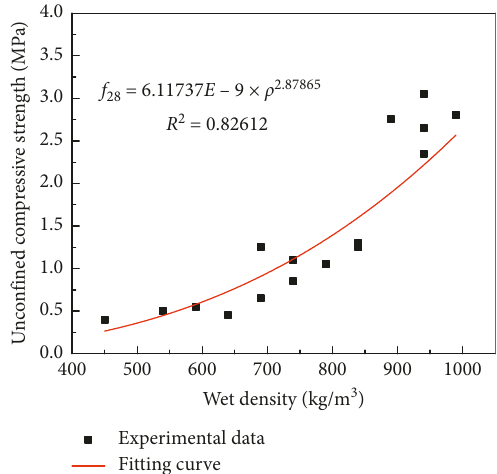
Figure 7: Fitting of the experimentally obtained wet density and compressive